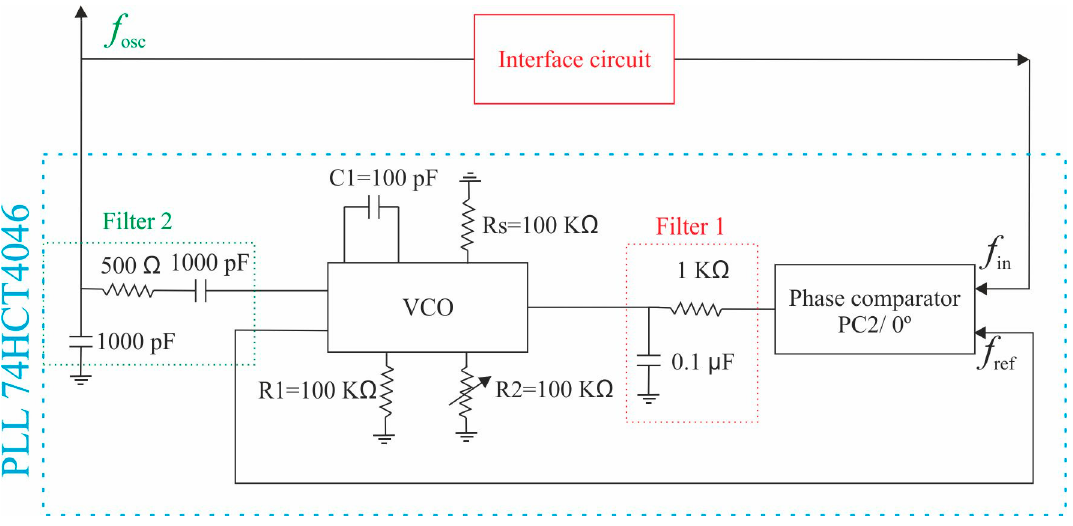
Figure 4. Schematic of phase-locked loop (PLL) 74HCT4046 oscillator circuit including the interface circuit.